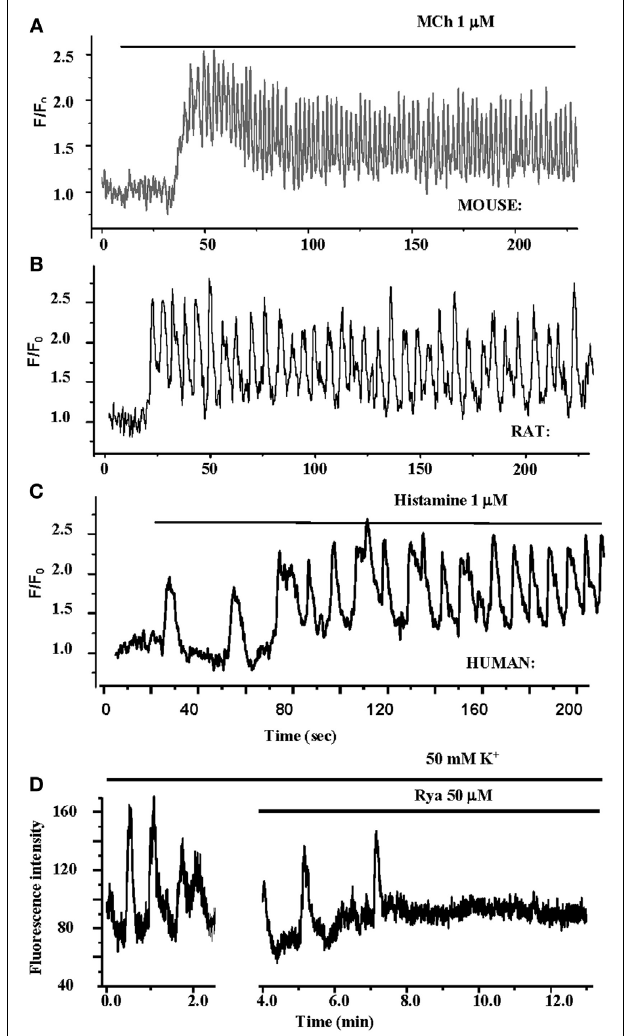
FIGURE 5 | Ca 2 + oscillations inASMCs in lung slices. (A–C) The contractile agonists methacholine and histamine induce Ca 2 + Oscillations in mouse, rat, and human ASMCs in lung slices.The frequency of the Ca 2 + oscillations varies between species. (D) KCl also induces Ca 2 + oscillations in human ASMCs in lung slices.Theses Ca 2 + oscillations are slow and are inhibited by RyR.